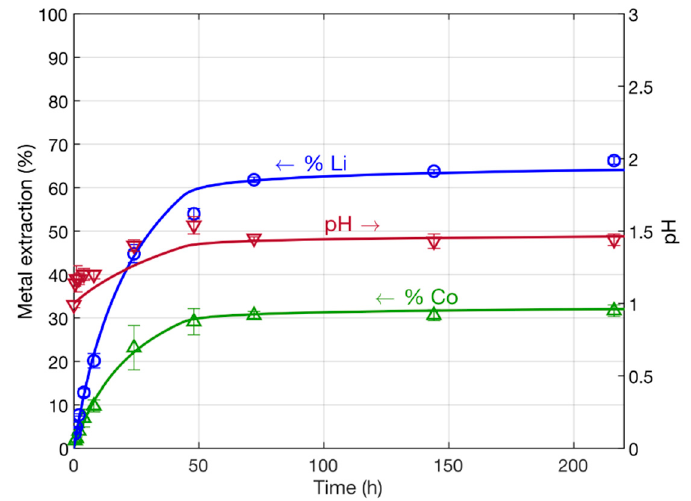
Figure 2. Experimental (marks) and simulation (lines) results for the case of 𝑆/𝐿 = 5 g/L in 0.1 M HCl.